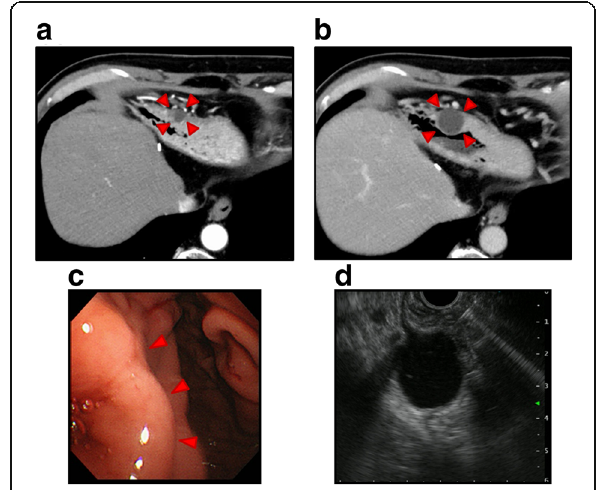
Fig. 3 Preoperative imaging of the cystic tumor in the gastric antrum. Enhanced CT showed a 15-mm cystic lesion of the gastric antrum ( a , arrowheads) 4 years after the initial operation. Six months later, the cystic lesion had grown up to 25 mm ( b , arrowheads). Endoscopy revealed no epithelial lesion ( c , arrowheads). Endoscopic ultrasonography showed a submucosal tumor ( d